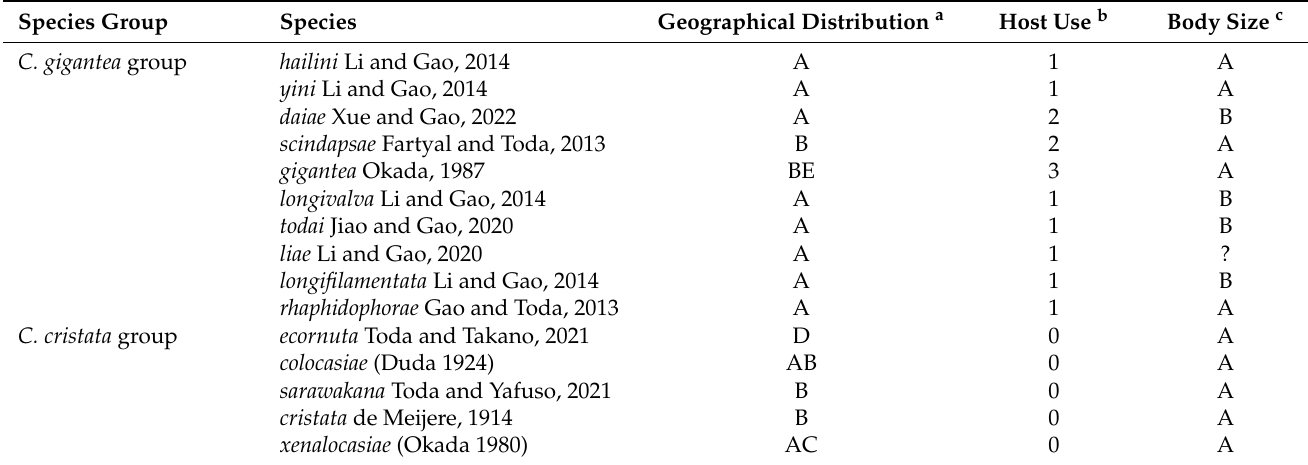
Table 2. Statuses of the distribution areas, host plant uses and body sizes of ten species in the Colocasiomyia gigantea group and five representative species from the C. cristata group. Species Group Species Geographical Distribution a Host Use b Body Size